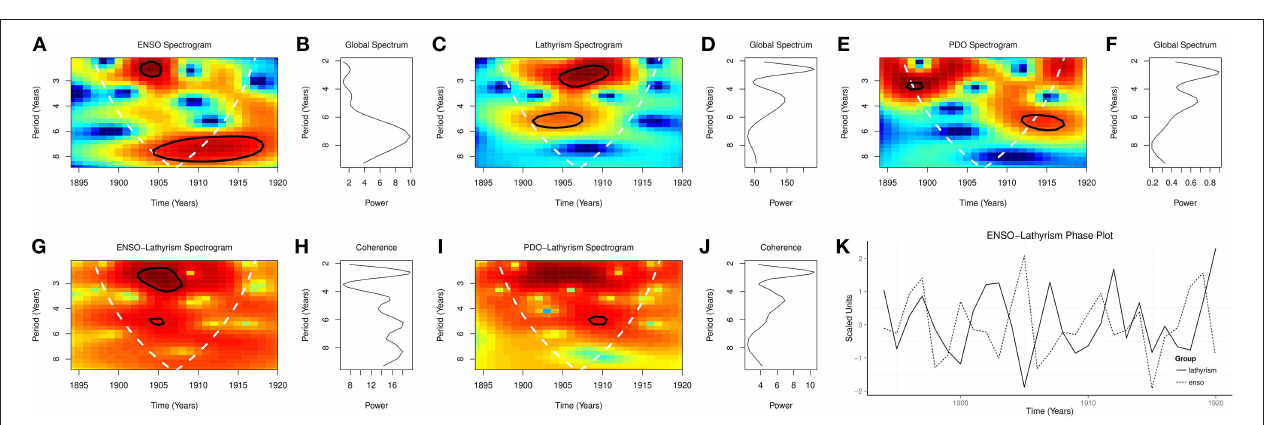
FIGURE 4 | Wavelet and cross-wavelet spectra of ENSO, PDO, and lathyrism epidemics.